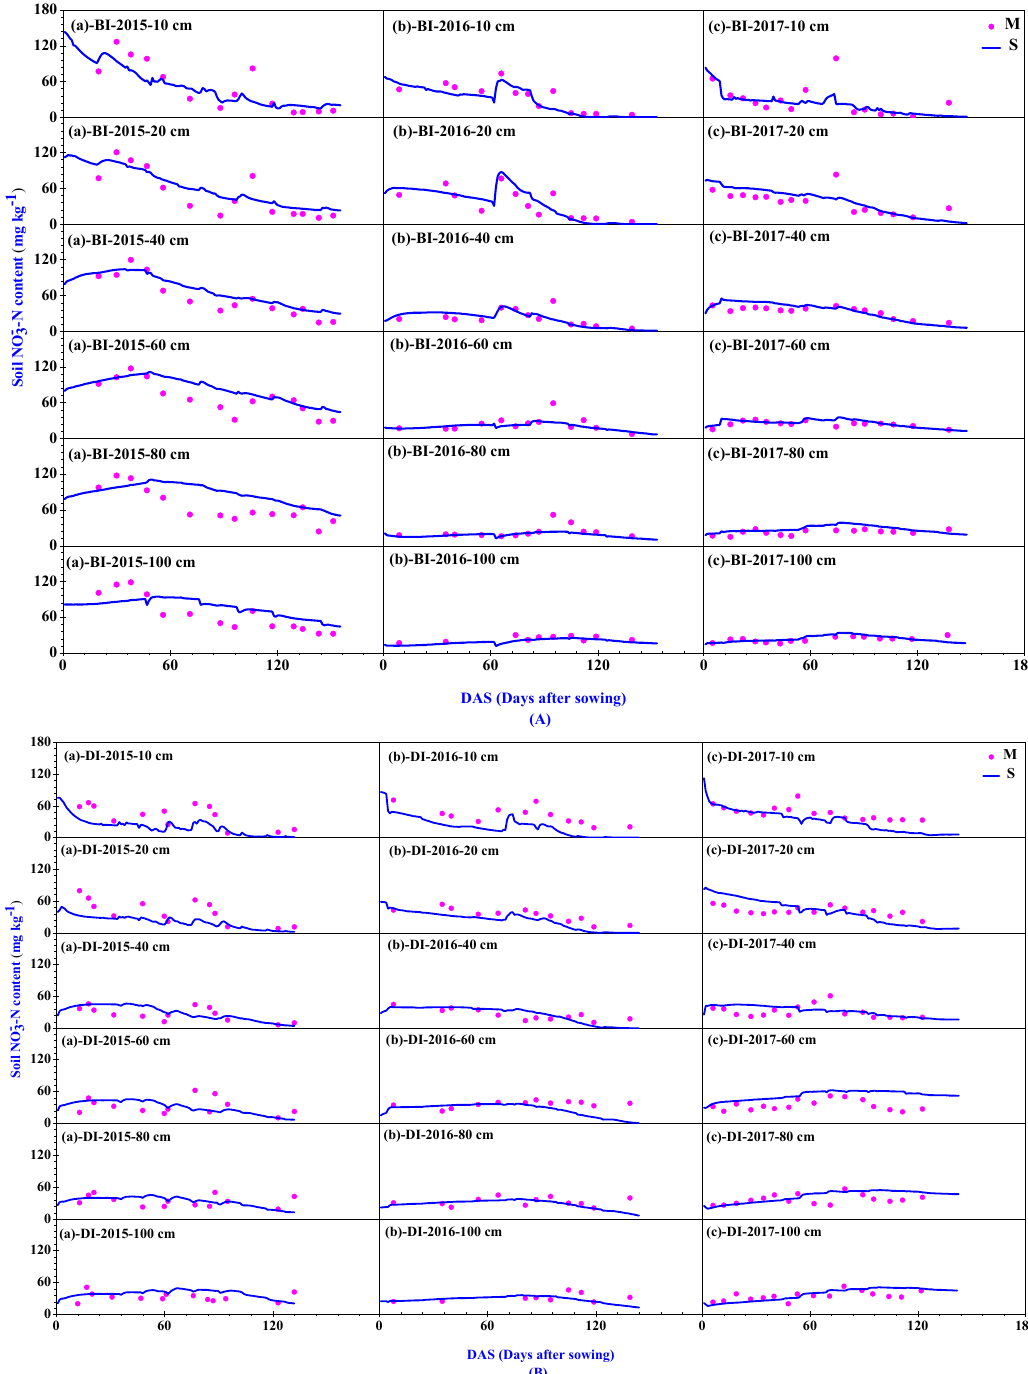
− -N content under -N content under 3 3